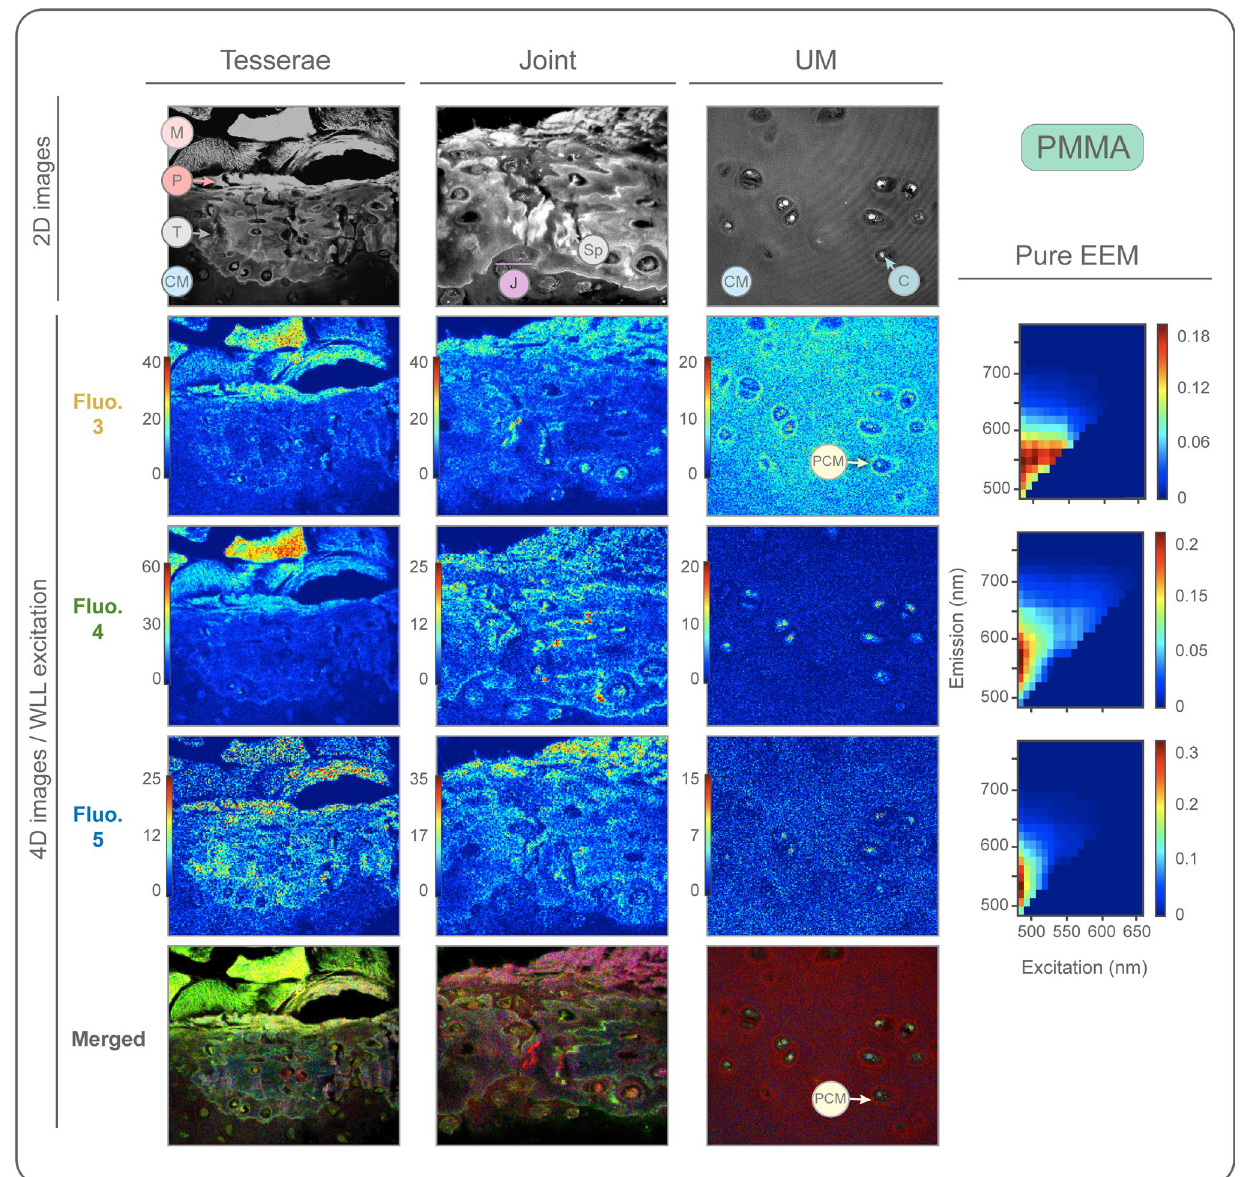
Fig. 11 Distribution maps and EEM of fluorescence signatures detected by MCR-ALS in PMMA samples excited with WLL. The 2D images (grayscale) images (top row) acquired with a 405 nm excitation laser and a wide wavelength emission filter provide reference for overall tis- sue appearance. The 4D images below show the distribution maps of each fluorescence signatures (Fluo. 3–5) identified (color bars indicate intensity). Excitation-emission (EEM) landscapes for each fluorescence signatures are shown to the right. At the bottom, merged distribution maps overlap both fluorescence signatures in the same image. Chondrocytes (C), Unmineralized cartilage matrix (CM), Joints (J), Perichon- drium (P), Tesserae